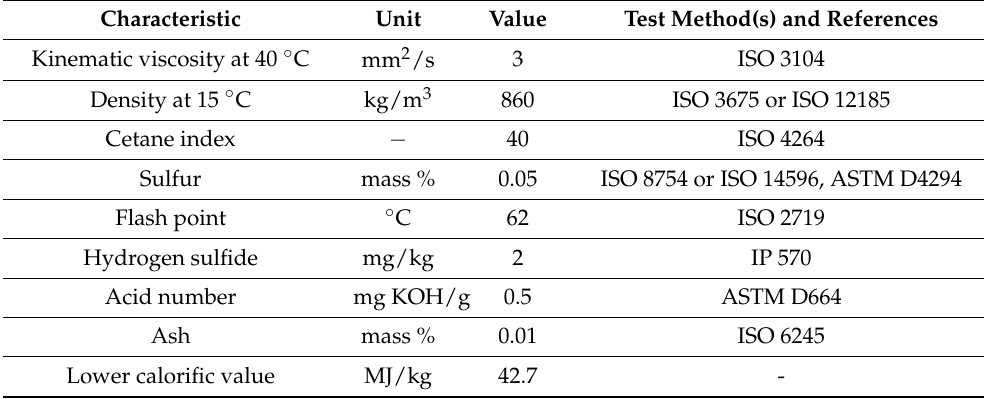
Table 5. Properties of standard MDO [19,20].